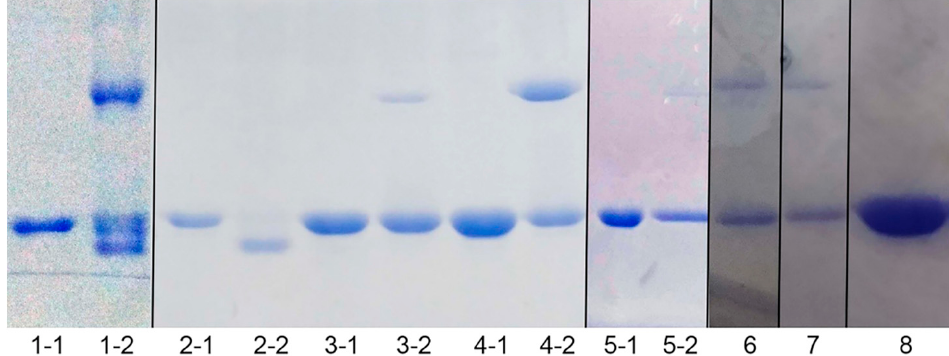
Figure 3. SDS − PAGE analysis of hGPx3 (U49S) and hGPx3 (U49S) mutants under reducing conditions with boiling treatment or non − reducing conditions without boiling treatment. Lanes are as